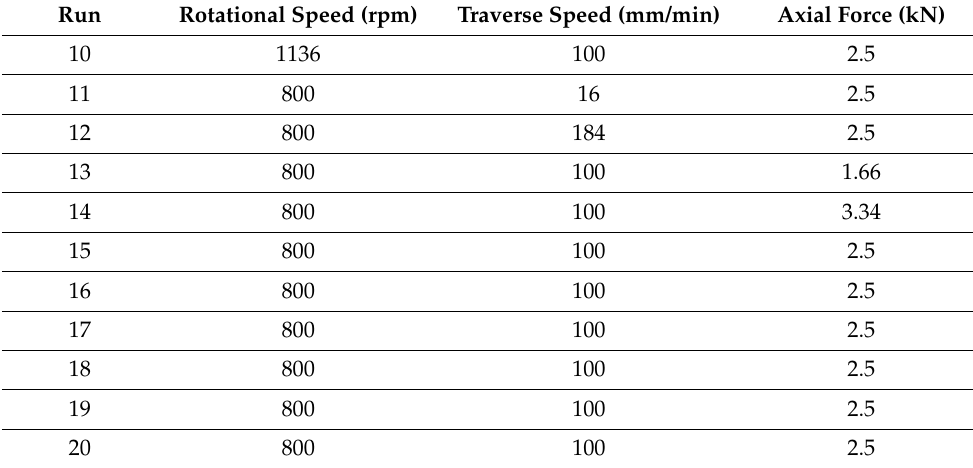
Figure 3. Nano-hardness and fuzzy nano-hardness results.